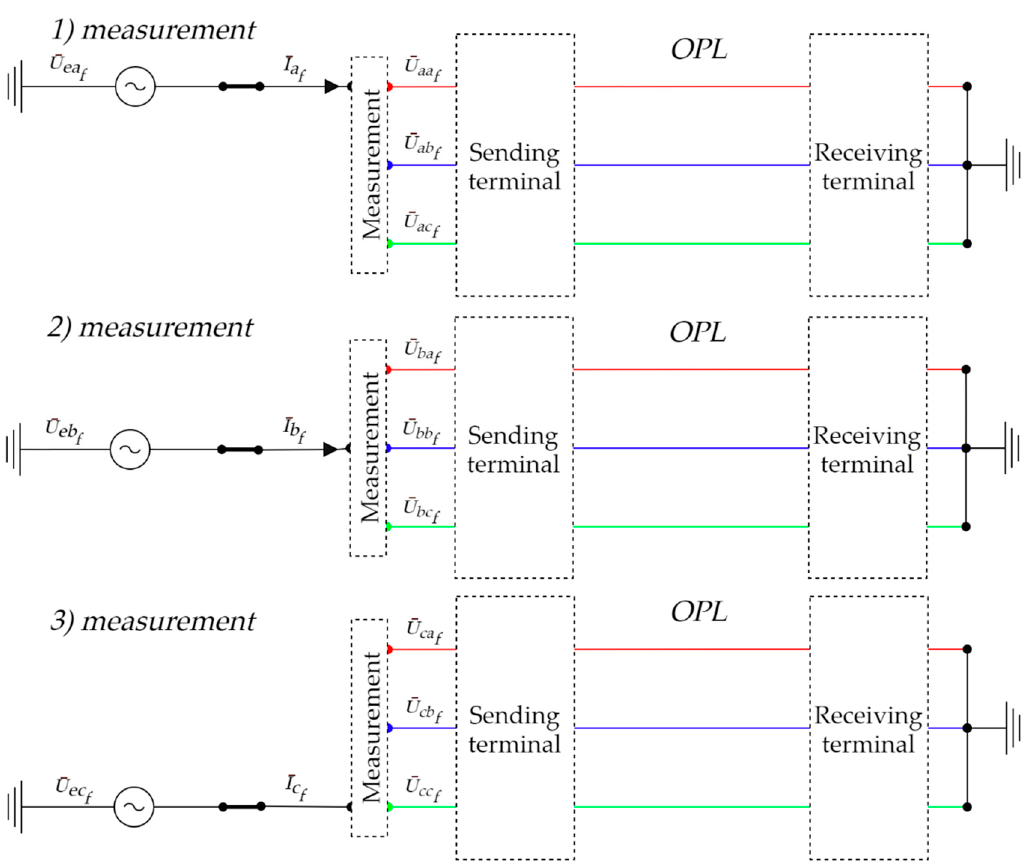
Figure 4. M3—Single phase measurement of positive and zero s equence impedance by phase-ground loops.